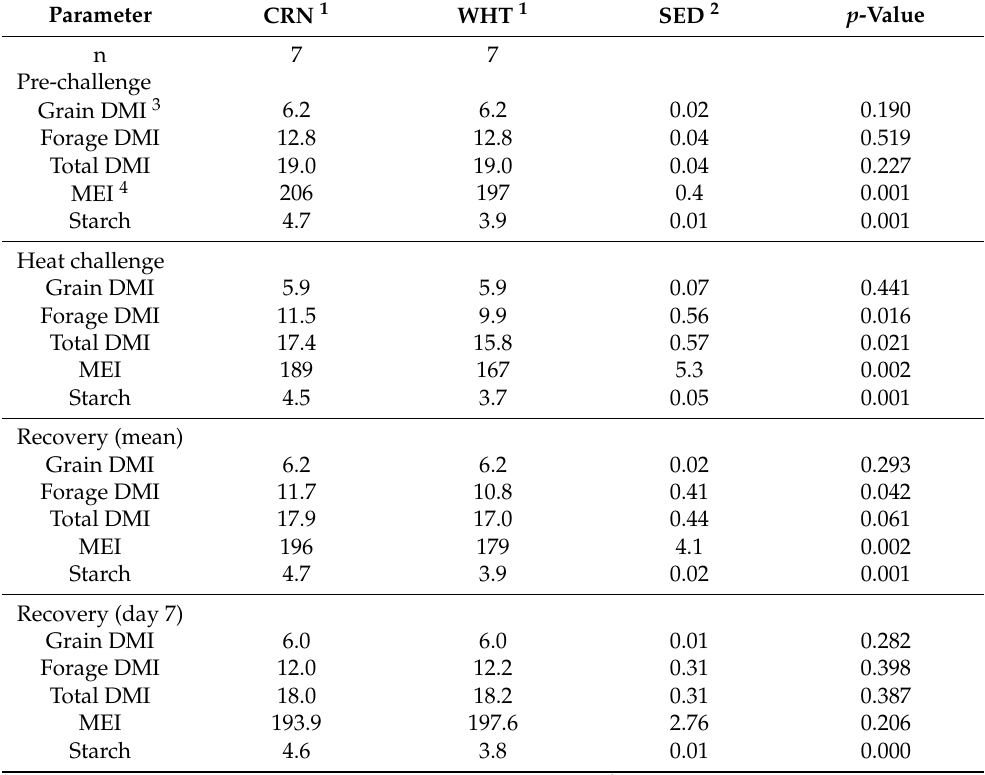
Table 2. Mean intake of total dry matter (kg/day), grain (kg/day), forage (kg/day), metabolizable energy (MJ/day), and starch (kg DMI/day) during each period of the experiment, and on day 7 of the recovery